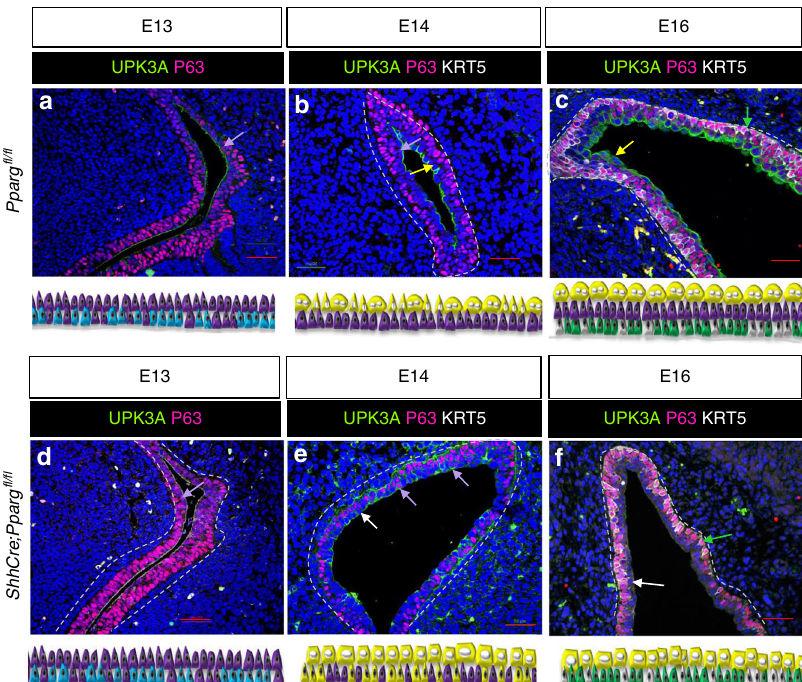
Fig. 3 Pparg controls I cell and S cell development. a , d Expression of Upk3a and P63 in the urothelium at E13 in a Pparg fl / fl control embryo ( a ) and in a Shh Cre ;Pparg fl / fl mutant embryo ( d ). b , e . Expression of Upk3a, Krt5, and P63 in the urothelium at E14 in a Pparg fl / fl control embryo ( b ) and in a Shh Cre ; Pparg fl / fl mutant embryo ( e ). c , f Expression of Upk3a, Krt5, and P63 in the urothelium at E16 in a Pparg fl / fl control embryo ( c ) and in a Shh Cre ;Pparg fl / fl mutant embryo ( f ). Yellow arrows denote S cells; white arrows denote abnormal S cells; purple arrows denote I cells; and green arrows denote basal cells. Samples used in this experiment: E16 mutant urothelium, n = 5; E16 control urothelium, n = 4; E14 mutant urothelium, n = 7, E14 control urothelium, n = 8; E13 mutant urothelium, n = 3; E13 control urothelium, n = 3. Scale bar: 50 μ